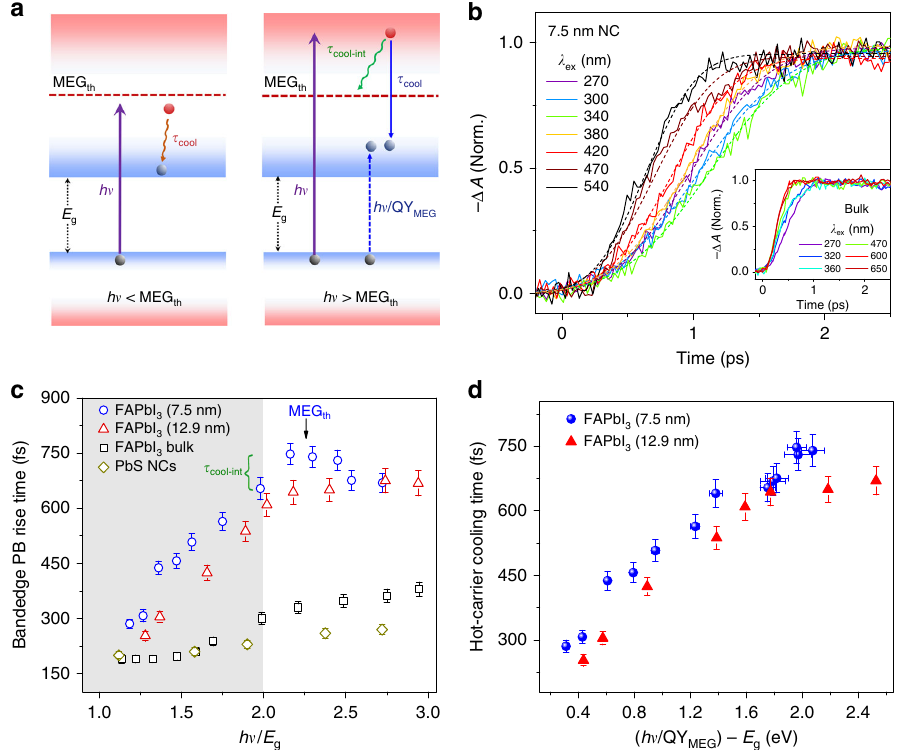
Fig. 4 Slower hot-carrier cooling in smaller FAPbI 3 NCs. a Schematic for hot-carrier cooling (left) below MEG threshold and (right) above the MEG threshold. b Normalized band-edge PB dynamics in colloidal 7.5 nm-sized FAPbI 3 NCs and their bulk-counterpart (inset) under different pump wavelengths. The dashed lines are single exponential fi ts. c Band-edge PB buildup-time of FAPbI 3 NCs (7.5 nm (blue circles); 12.9 nm (red triangles)), polycrystalline bulk- fi lm (black square), and PbS NCs (yellowish-brown diamonds) measured at different pump photon energies. Gray region indicates the energies below ideal MEG threshold of 2 E g . d Hot-carrier cooling time as a function of converted real excess energies of carriers in FAPbI 3 NCs. The error bars in ( c ) and ( d ) represent the uncertainty in the fi tting procedure for the rise densites 24 , the effective volume carrier density in NC and bulk samples were kept constant at 2 × 10 17 cm − 3 .